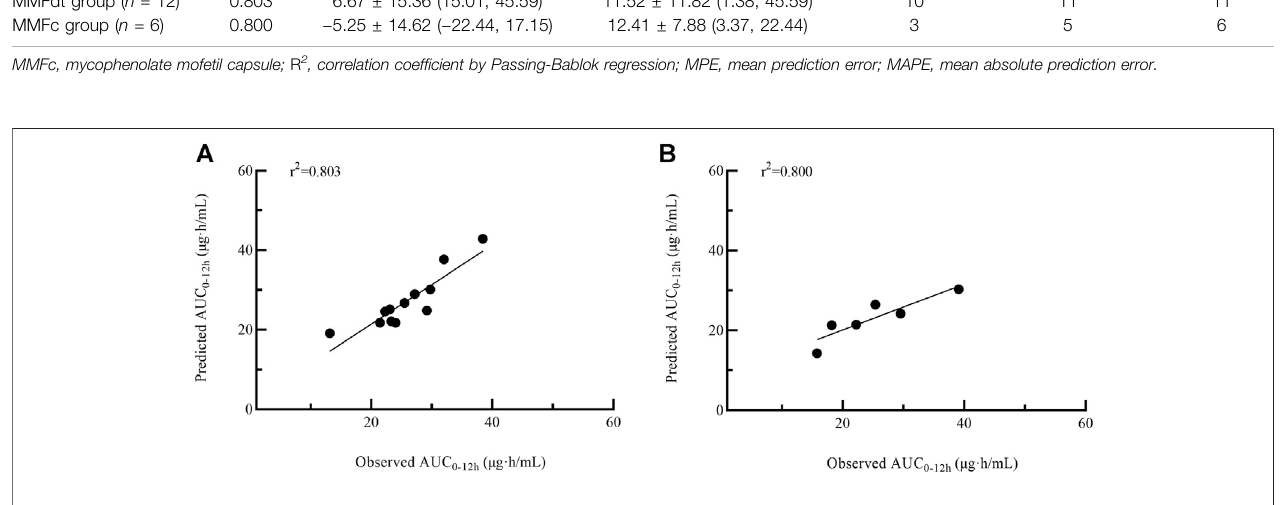
FIGURE 4 | Passing – Bablok regression analysis between the observed AUC 0 – 12h and the predicted AUC 0 – 12h of MPA obtained from model validation group (A) and MMFc group (B) by model 4. AUC 0 – 12h , the area under the 12 h concentration-time curve; MPA, mycophenolic acid; MMFc, mycophenolate mofetil capsule.